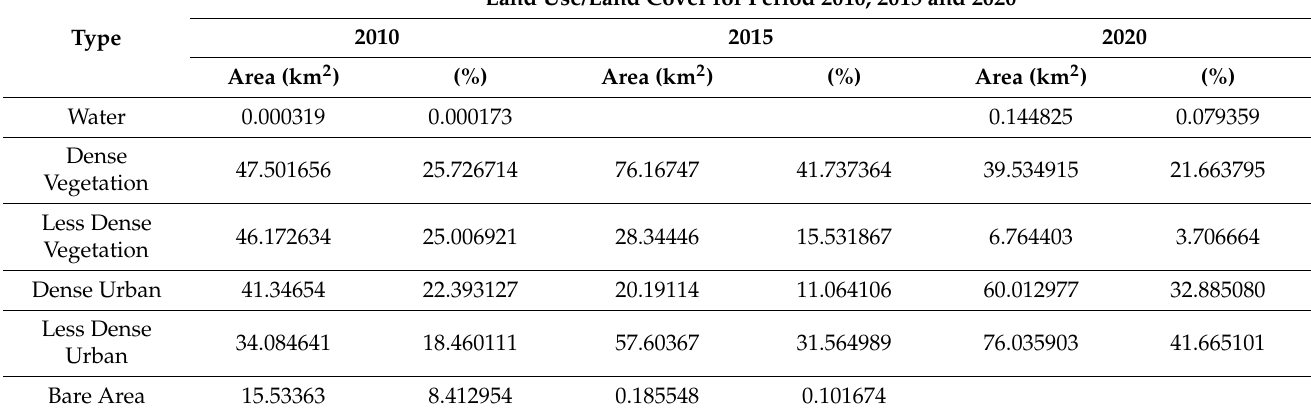
Table 2. Land used/cover summary.